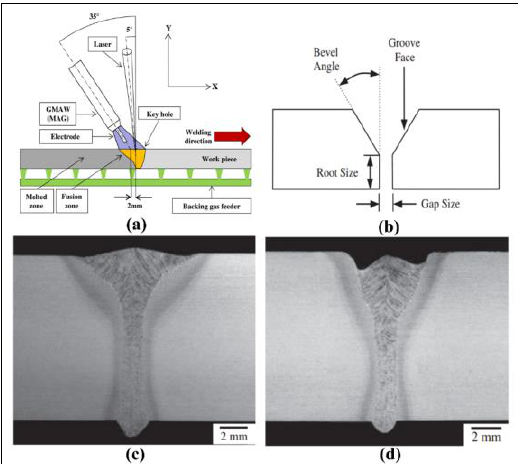
Figure 14. ( a ) LAHW system with laser leading mode; ( b ) Schematic of groove shape; ( c ) Laser- leading HLAW with joint gaps at a root size of 2 mm; ( d ) MAG-leading HLAW with gaps at a root size of 2 mm [82]. Reprinted with permission from [82] 2016 Elsevier.